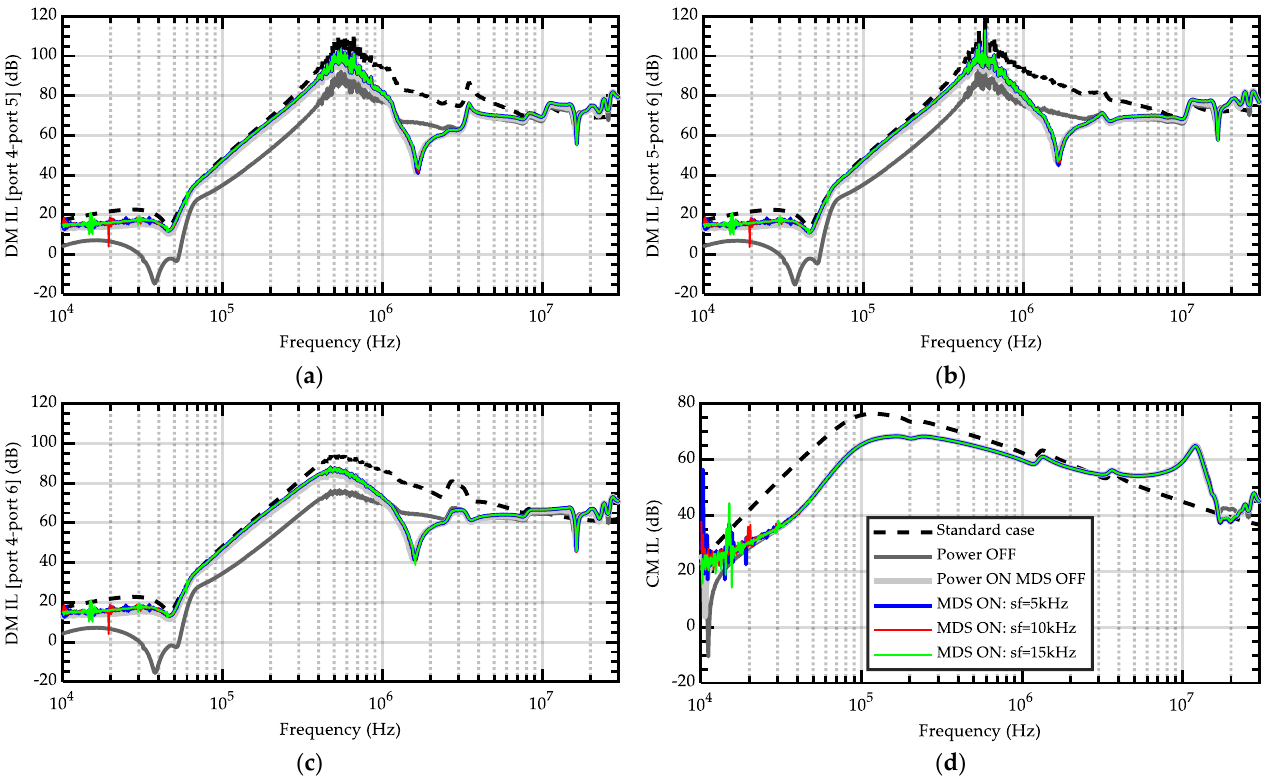
Figure 12. One-stage filter: DM ILs between ( a ) port 4–5, ( b ) port 5–6 and ( c ) port 4–6, and ( d ) CM IL.